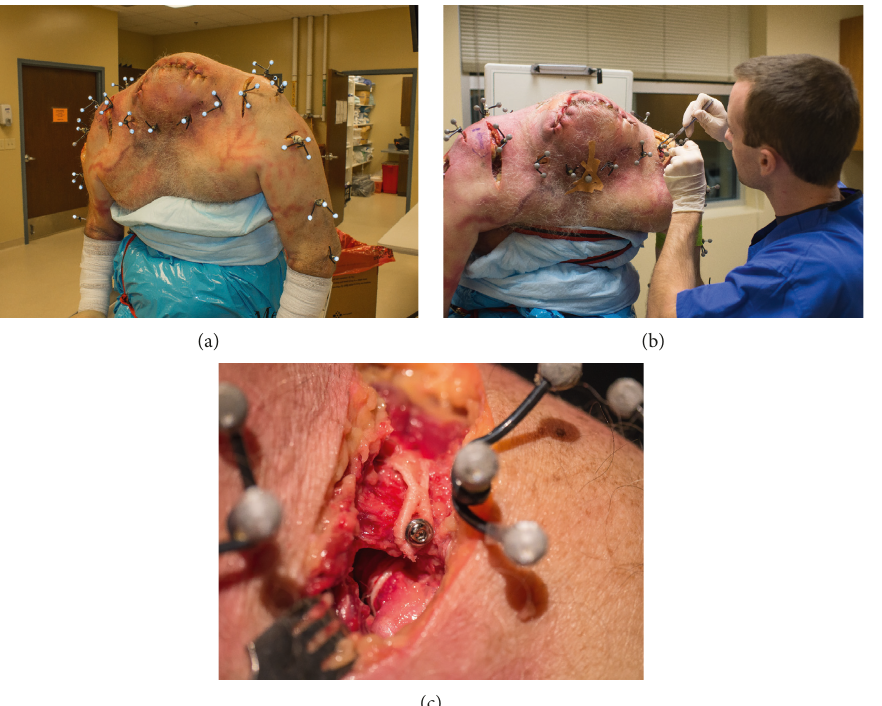
Figure 2: Cadaveric models were used to describe the acromioclavicular distance using biomechanical motion analysis in the “native” (a), “severed” (b), and “reconstructed” (c)